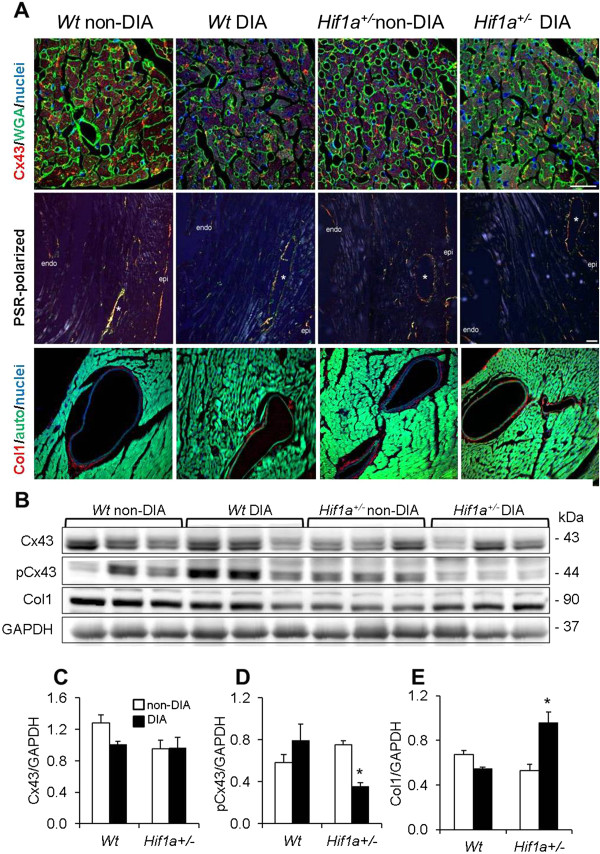
Effects of diabetes on structural remodeling and protein levels in the Wt and Hif1a+/-LV. (A) Representative of immunofluorescence confocal and light microscopy images of the hearts stained with anti-connexin 43 (Cx43, red) together with fluorescein-labeled wheat germ agglutinin (WGA, green); with picrosirius red (PSR, polarizing microscopy); and with anti-collagen 1 (Col1, red), autofluorescence (auto) are shown. The nuclei were counterstained with Hoechst 33342 (blue). Confocal images are stacked Z-plane sections from confocal microscopy. Scale bar: Cx43/WGA 25 μm, PSR 50 μm, Col1 25 μm. (B) Representative Western blot analyses of protein lysates from the isolated LVs of Wt and Hif1a+/- non-diabetic and diabetic hearts are shown. (C-E) A relative quantification of protein levels of Cx43, phosphoCx43 (pCx43), and Col1 (n = 3 per group) was performed. The bar graphs show the mean values of relative protein levels normalized to the loading control (GAPDH) ± SEM from densitometric analysis. *P < 0.05 (2-way ANOVA with Tukey’s post-test).